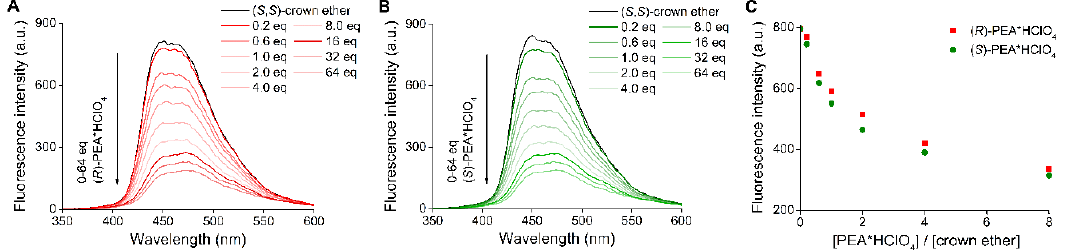
Figure 8. Fluorescence quenching of ( S , S )- 2 upon titration with perchlorate salts of PEA enantiomers ( R )- 22 ( A ) and ( S )- 22 ( B ) and the titration curves ( C ).